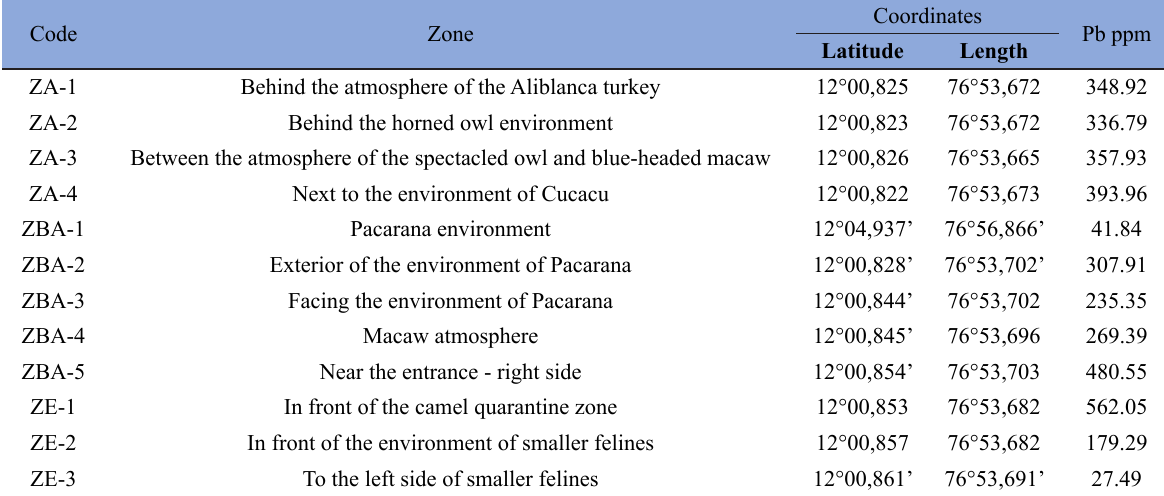
Table 3 : Initial lead content in the study